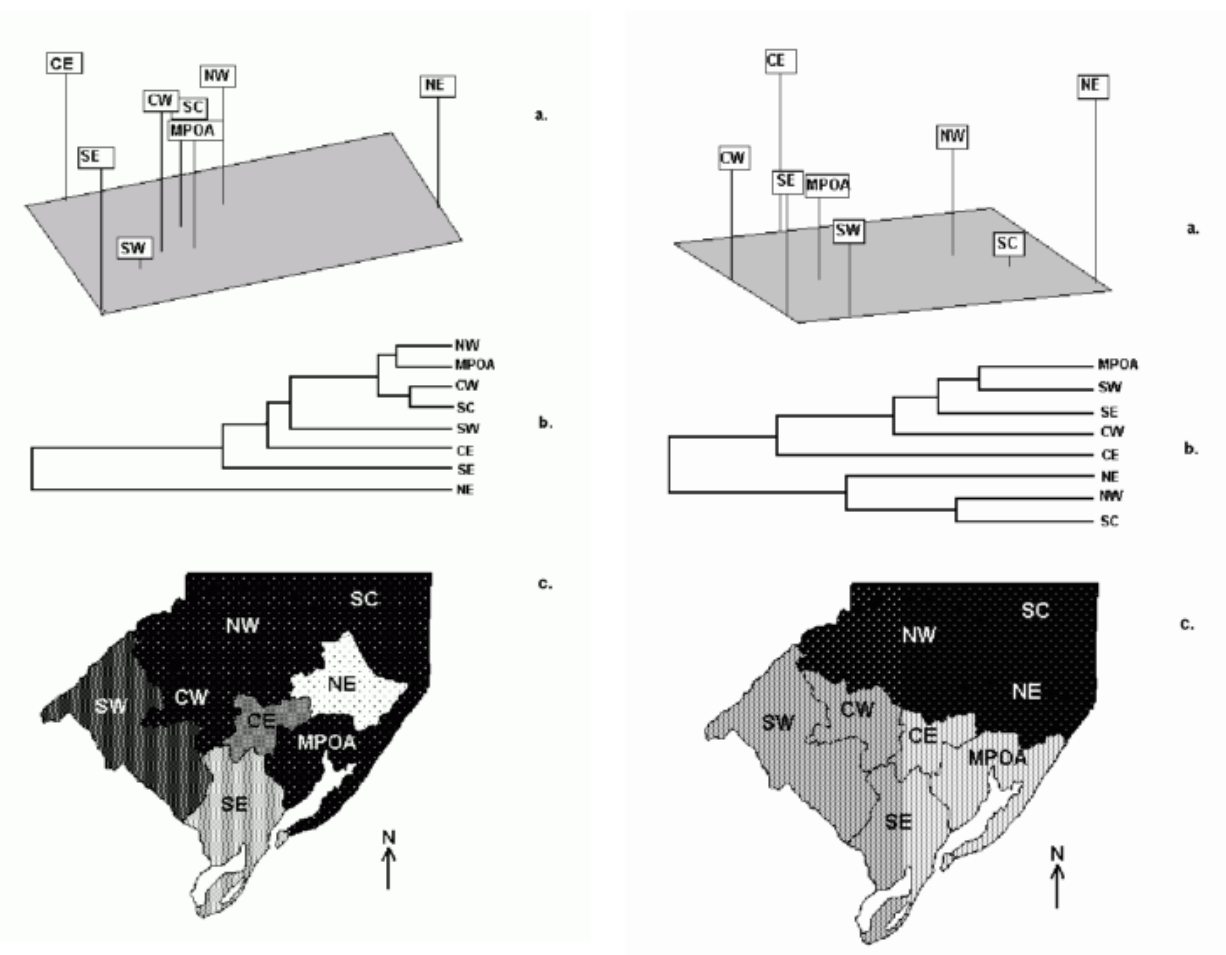
Figure 2 - Multivariate analyses of the distribution of grandparents’ nation- alities: (a) principal coordinates, (b) dendrogram obtained from the D A dis- tances, (c) map of both distributions. Shading is arbitrary, but indicates the major associations among mesoregions.